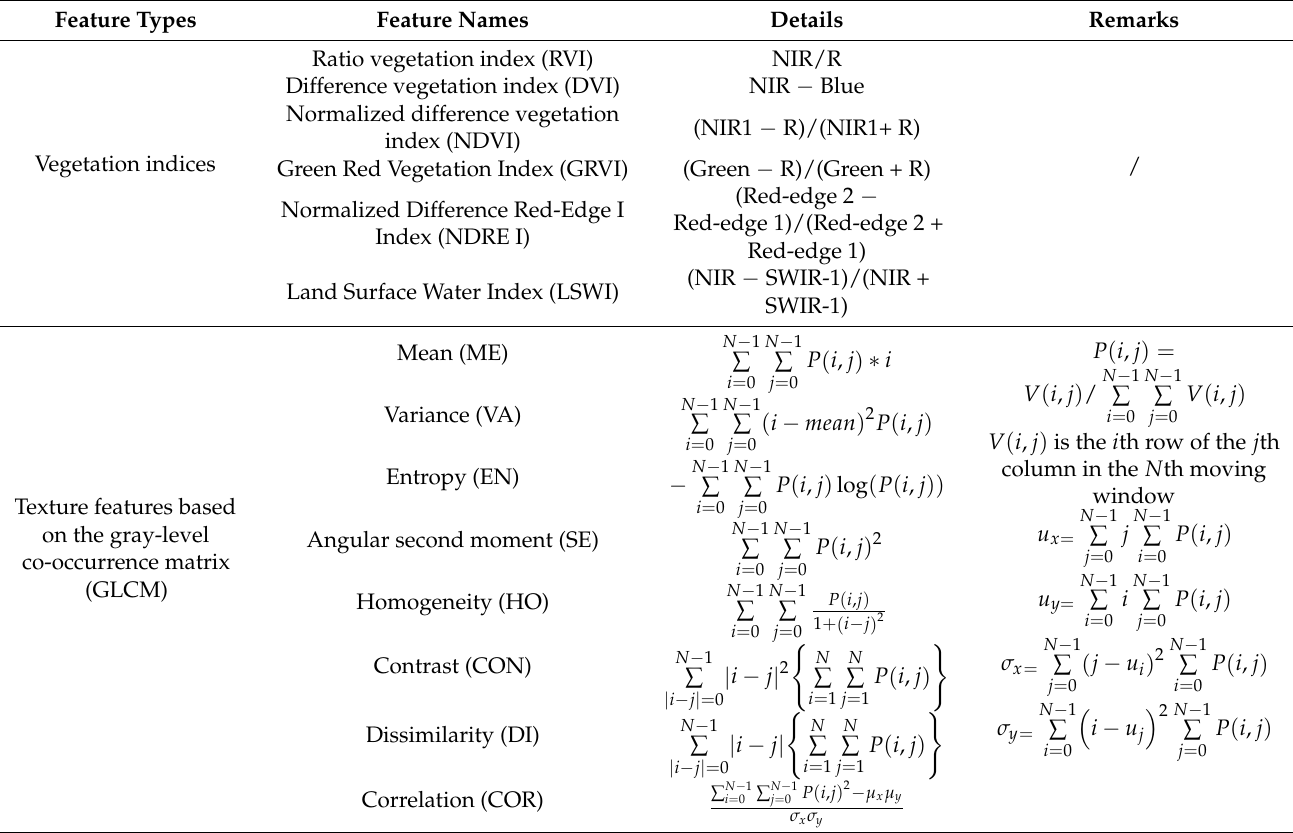
Table 2. Vegetation Index and Texture Feature